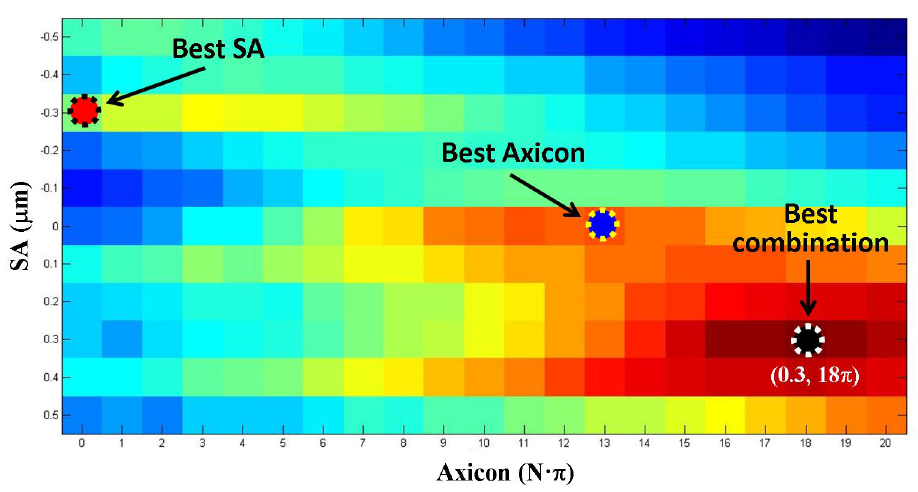
Figure 4. Map of TPEF signal for different combinations of SA and axicon. The sample is the same piece of cellulose used in previous figures.